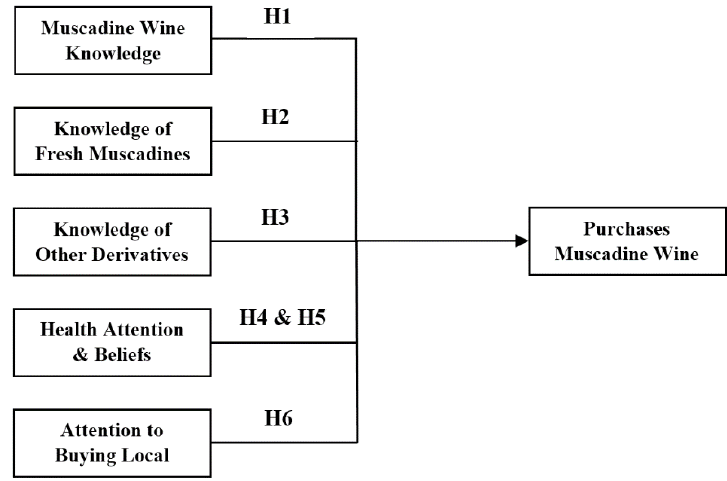
Figure 1. Outline of research constructs in the muscadine wine study.